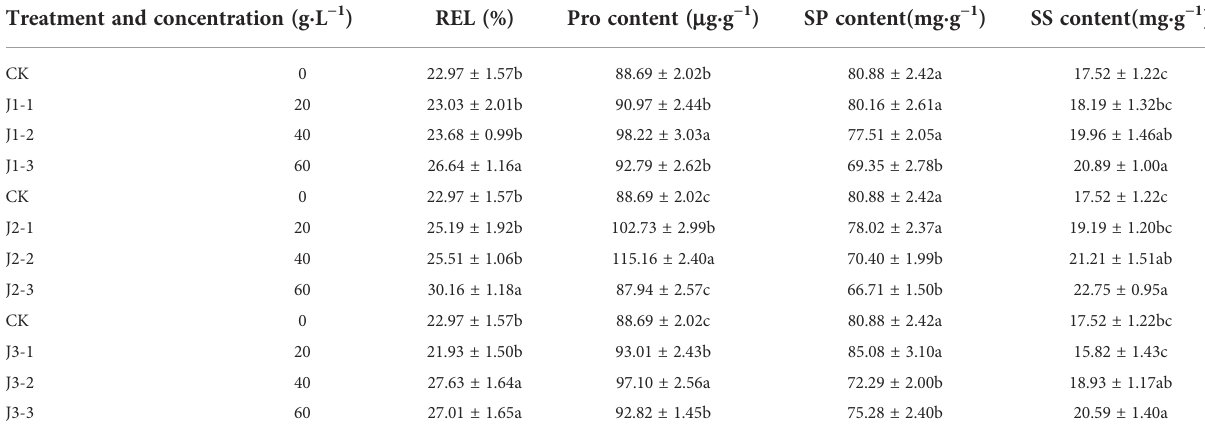
Different lowercase letters in each column represent signi fi cant differences at the 5% level between different concentrations of root aqueous extract with the same ratoon age. REL, relative electrolyte leakage; Pro, proline; SP, soluble protein; SS, soluble sugar; CK, control